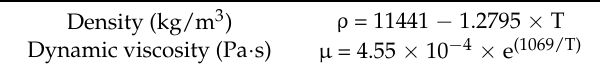
Table 3. Liquid lead properties equations [8], T is the Temperature expressed in K.